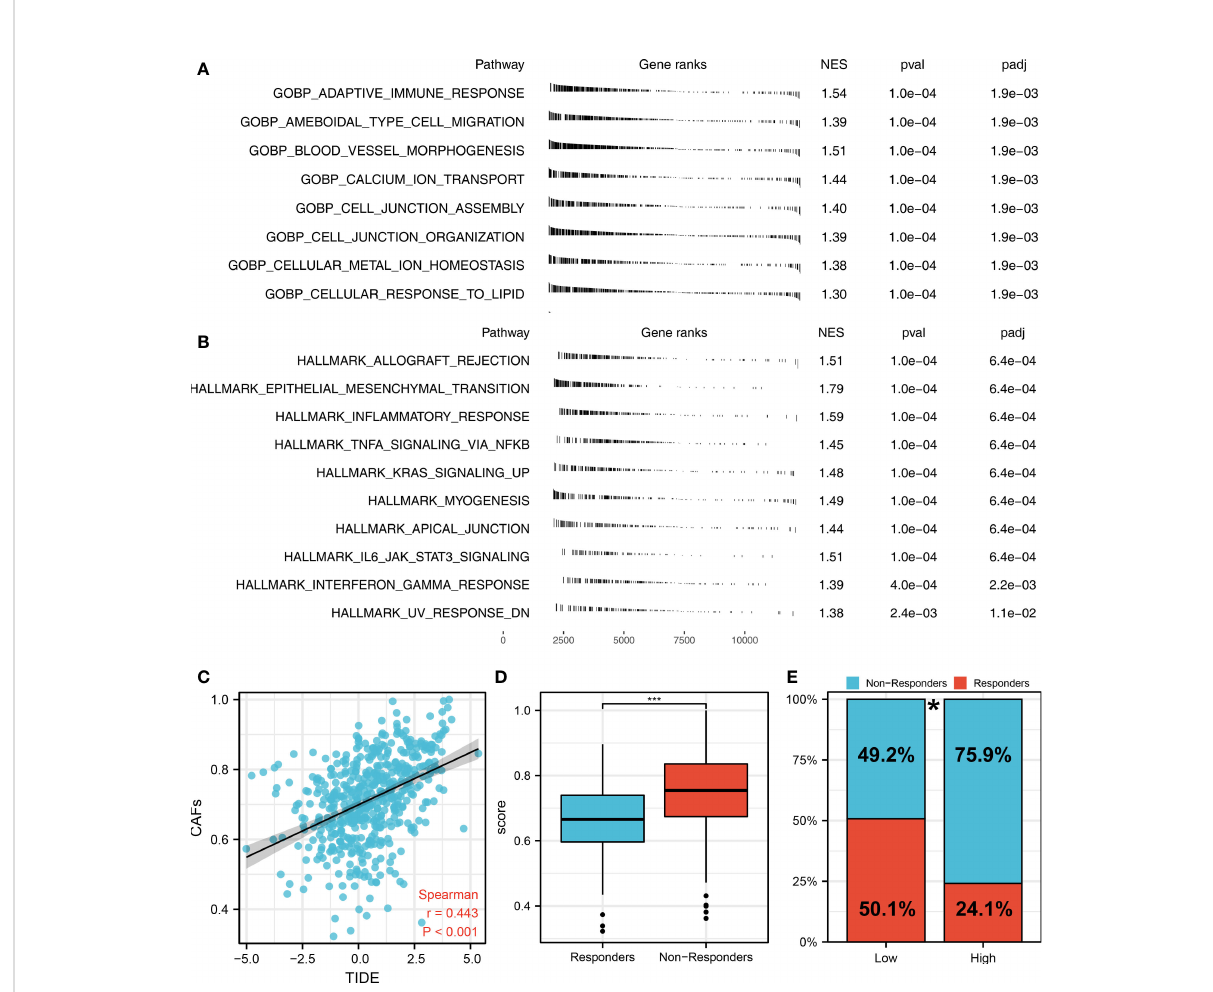
FIGURE 2 The role of CAFs in affecting lung cancer biological pathways and immunotherapy response. (A) The GSEA analysis between high- and low- CAFs groups based on the Hallmark gene set; (B) The GSEA analysis between high- and low-CAFs groups based on the GO gene set; (C) Correlation analysis between TIDE score and CAFs score; (D) CAFs level in immunotherapy responders and non-responders ***P < 0.001; (E) Percentage of immunotherapy responders in patients with high and low CAFs in fi ltration, *P <